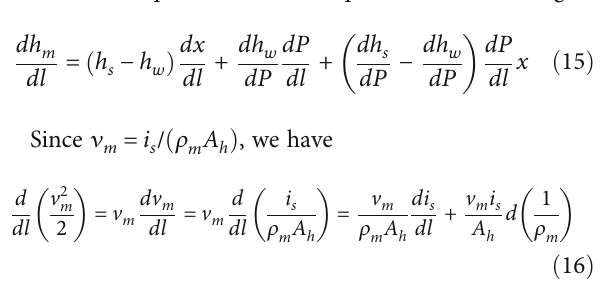
Figure 5: Work fl ow of model